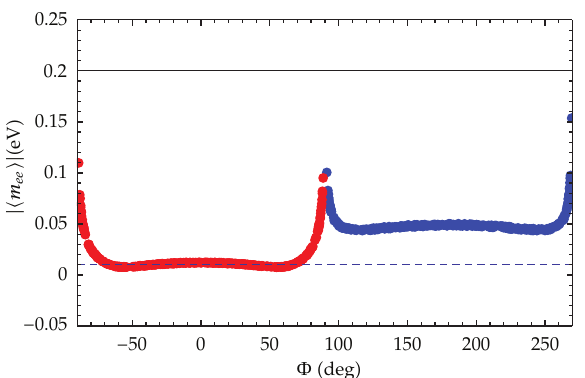
Figure 5: Prediction of the e ff ective mass |(cid:2) m ee (cid:3)| responsible for 0 ν 2 β as a function of φ by the 1 σ experimental constraints (cid:2) 2.9 (cid:3) . The blue (cid:2) dark (cid:3) and red (cid:2) light (cid:3) curves correspond to the IH and NH ordering.